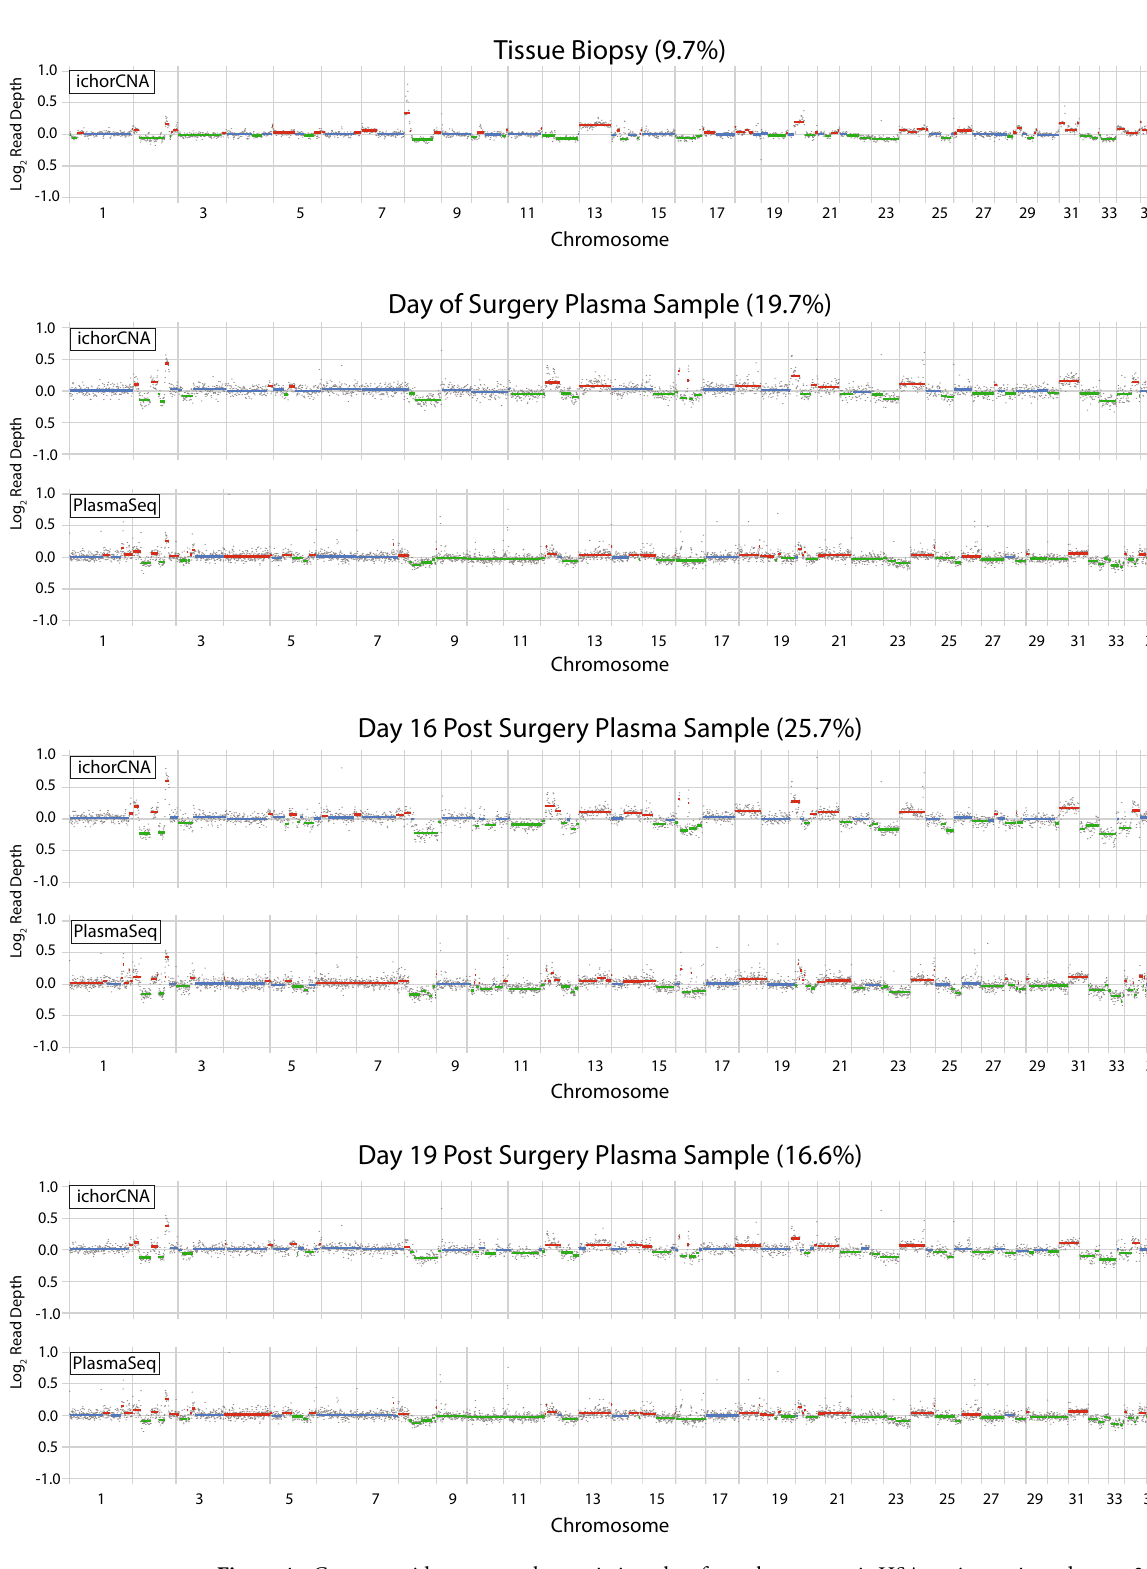
Figure 4. Genome-wide copy number variation plots from the metastatic HSA canine patient, dog no. 26, representing the plasma and tumor biopsy sWGS from day of surgery, and plasma sWGS from days 16 and 19, both after the splenectomy